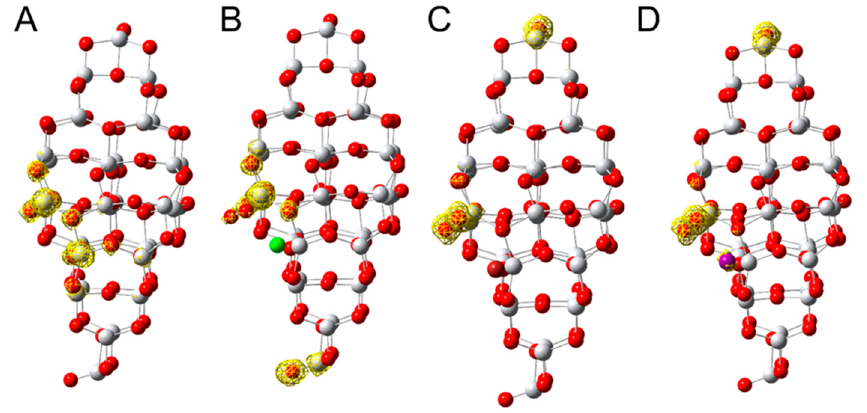
Figure 5. Ti 35 O 69 model of oxygen vacancy, (the oxygen vacancy formation for the depicted Ti 35 O 69 structure amounts to 4.17 eV [20]), ( A ) without and ( B – D ) with oxygen and X − interacting with the system. Red and white spheres correspond to oxygen and titanium atoms while green, brown and violet spheres are chlorine ( B ), bromine ( C ) and iodine ( D ) atoms, respectively. The yellow meshes stand for spin density for isosurface of 0.002 e / (a.u) 3 calculated at the PM6 level—single electron (multiplicity equal to 3) is localized to each Ti 3 + cation forming the vacancy ( A ) or is moved to the tip oxygen due to interaction with X − ( B